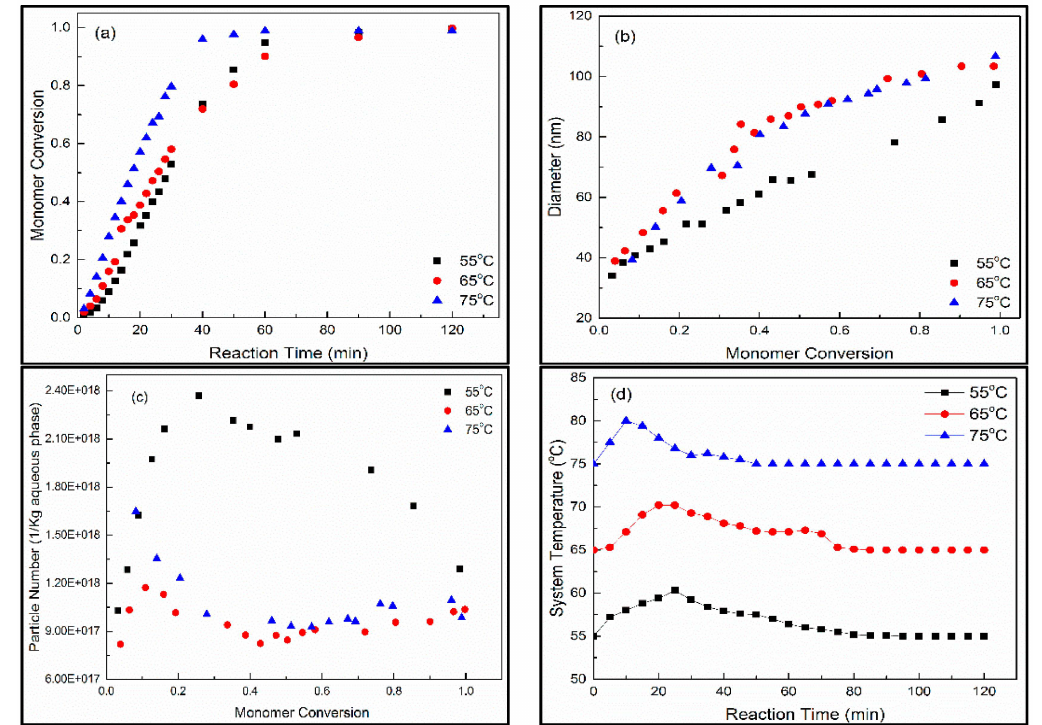
Figure 5. Plots of monomer conversion ( a ); particle size ( b ); number ( c ); and system temperature ( d ) against reaction time (or monomer conversion) for the emulsion polymerization of styrene using methanol solution (20/80 w / w ) as the polymerization medium and various reaction temperatures (55, 65, and 75 ˝